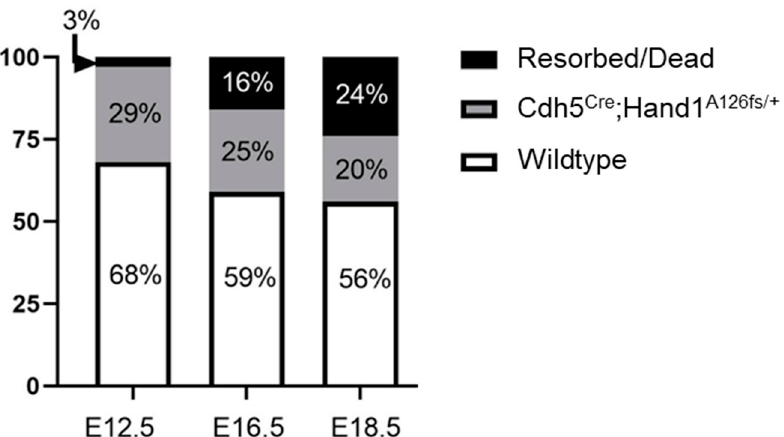
Figure 6. Percentage of resorptions (black), Cdh5 Cre+ ;Hand1 A126fs/+ (grey) and wildtype (white) fetuses in litters recovered at embryonic day 12.5 (E12.5), E16.5 and E18.5. As gestation progressed, the per- centage of resorptions/dead fetuses increased while the percentage of Cdh5 Cre ;Hand1 A126fs/+ fetuses decreased. Numbers in parentheses are the total number of pups at each timepoint. n = 3–8 dams. 2.6. Fetal and Placental Weights Were Reduced in Cdh5 cre ; Hand1 A126fs/+ by